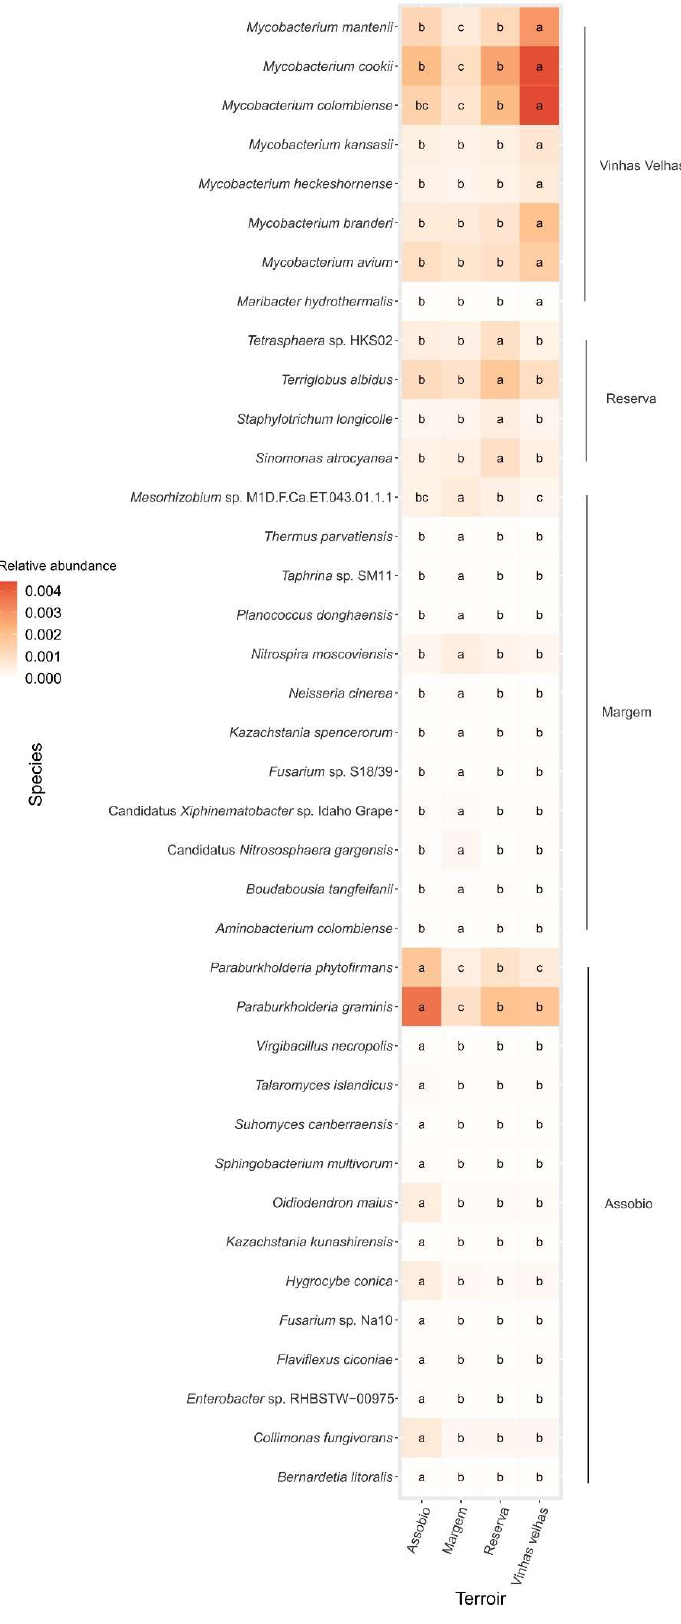
Figure 8. Relative abundance of terroir identified indicator species (average, N = 9). Letters denote significant differences at p < 0.05 between terroirs.